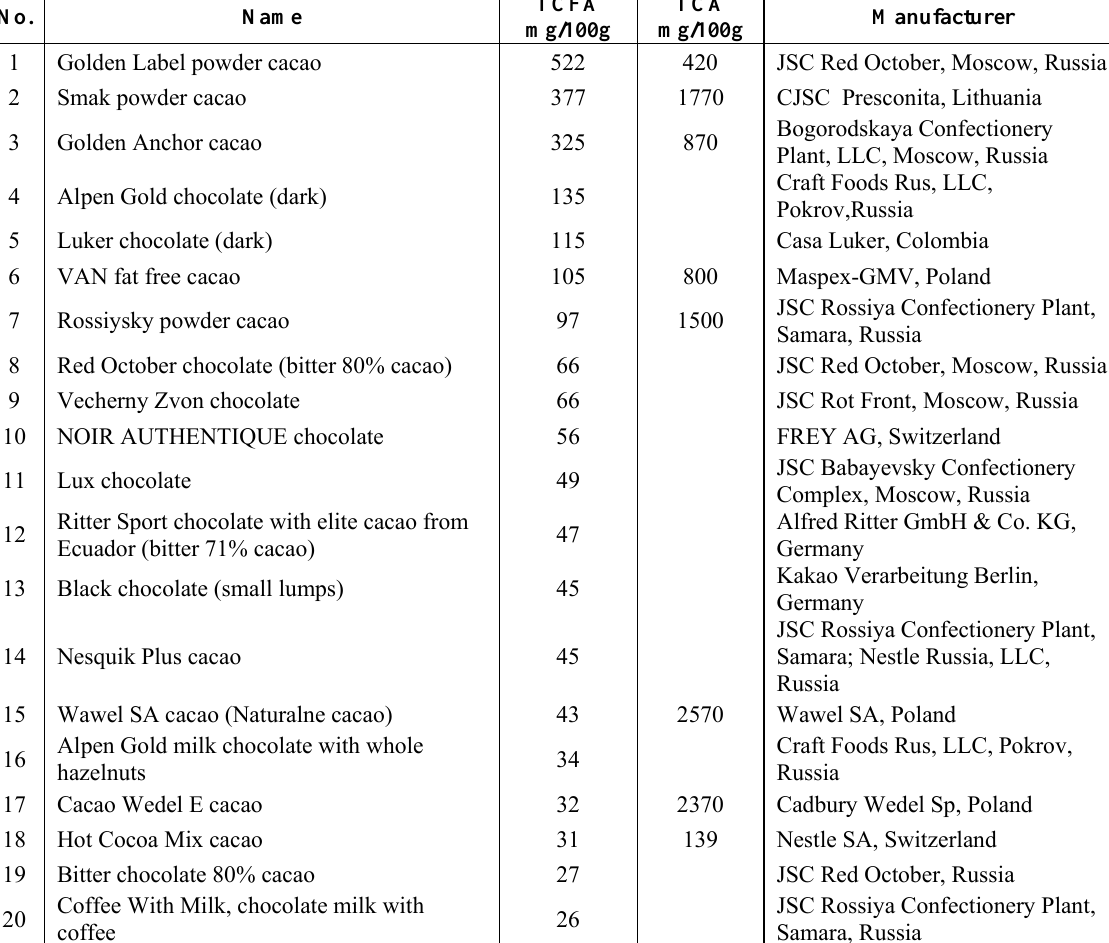
Table 6. Total Content of Fat-Soluble Antioxidants (TCFA) (standard - gallic acid) and Water-Soluble Antioxidants (TCA) in Cacao, Chocolate.